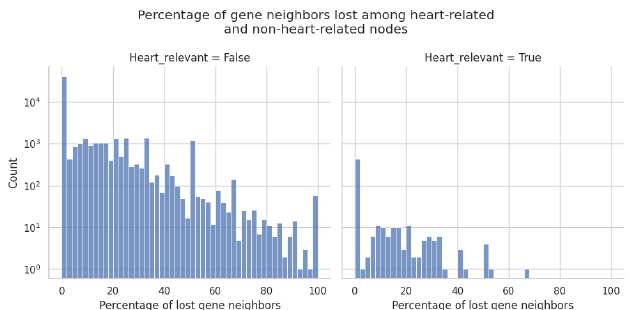
Figure 4. Distribution of the edges lost to gene and protein node neighbors for the kidney-specific KG. Given a list of kidney-related nodes (based on their label), we calculate the percentage of gene- or protein-adjacent node neighbors lost ( right panel ). When compared to the percentage of adjacent gene/protein neighbors lost for the remainder of (i.e., non-kidney-related) nodes, we can see a significant increase in gene–>concept edges lost, many of them losing up to all gene or protein neighbors ( left panel ).